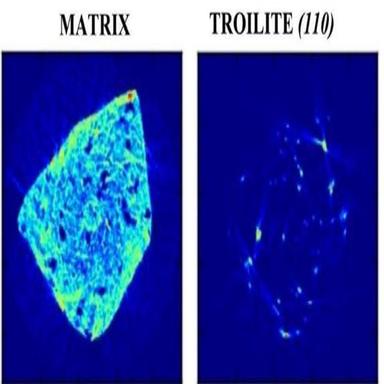
XRDCT reconstruction images showing the spatial distribution of the main phases within the meteorite.